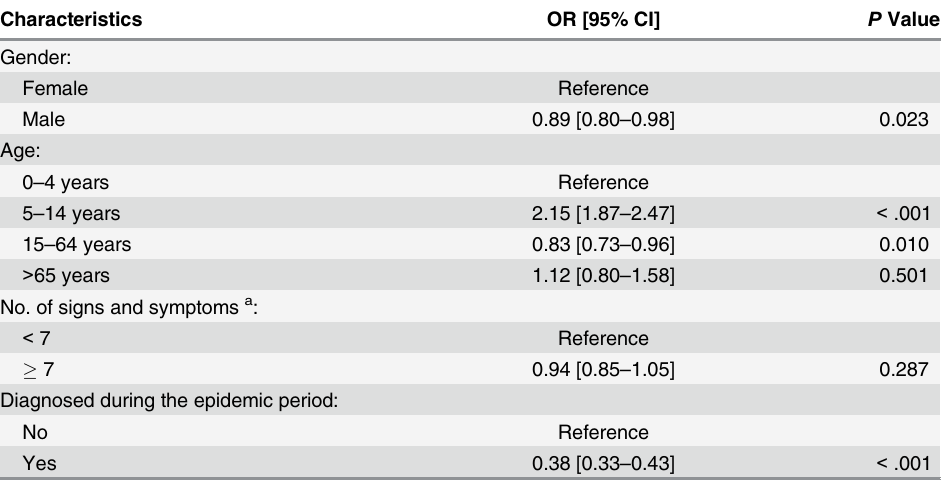
Table 5. Variables associated with the odds of having been infected with influenza type B vs. A viruses. Multivariable logistic regression analysis adjusted by season. The IBVD (Influenza B in Vircases database) study, France, 2003 – 2004 to 2012 –